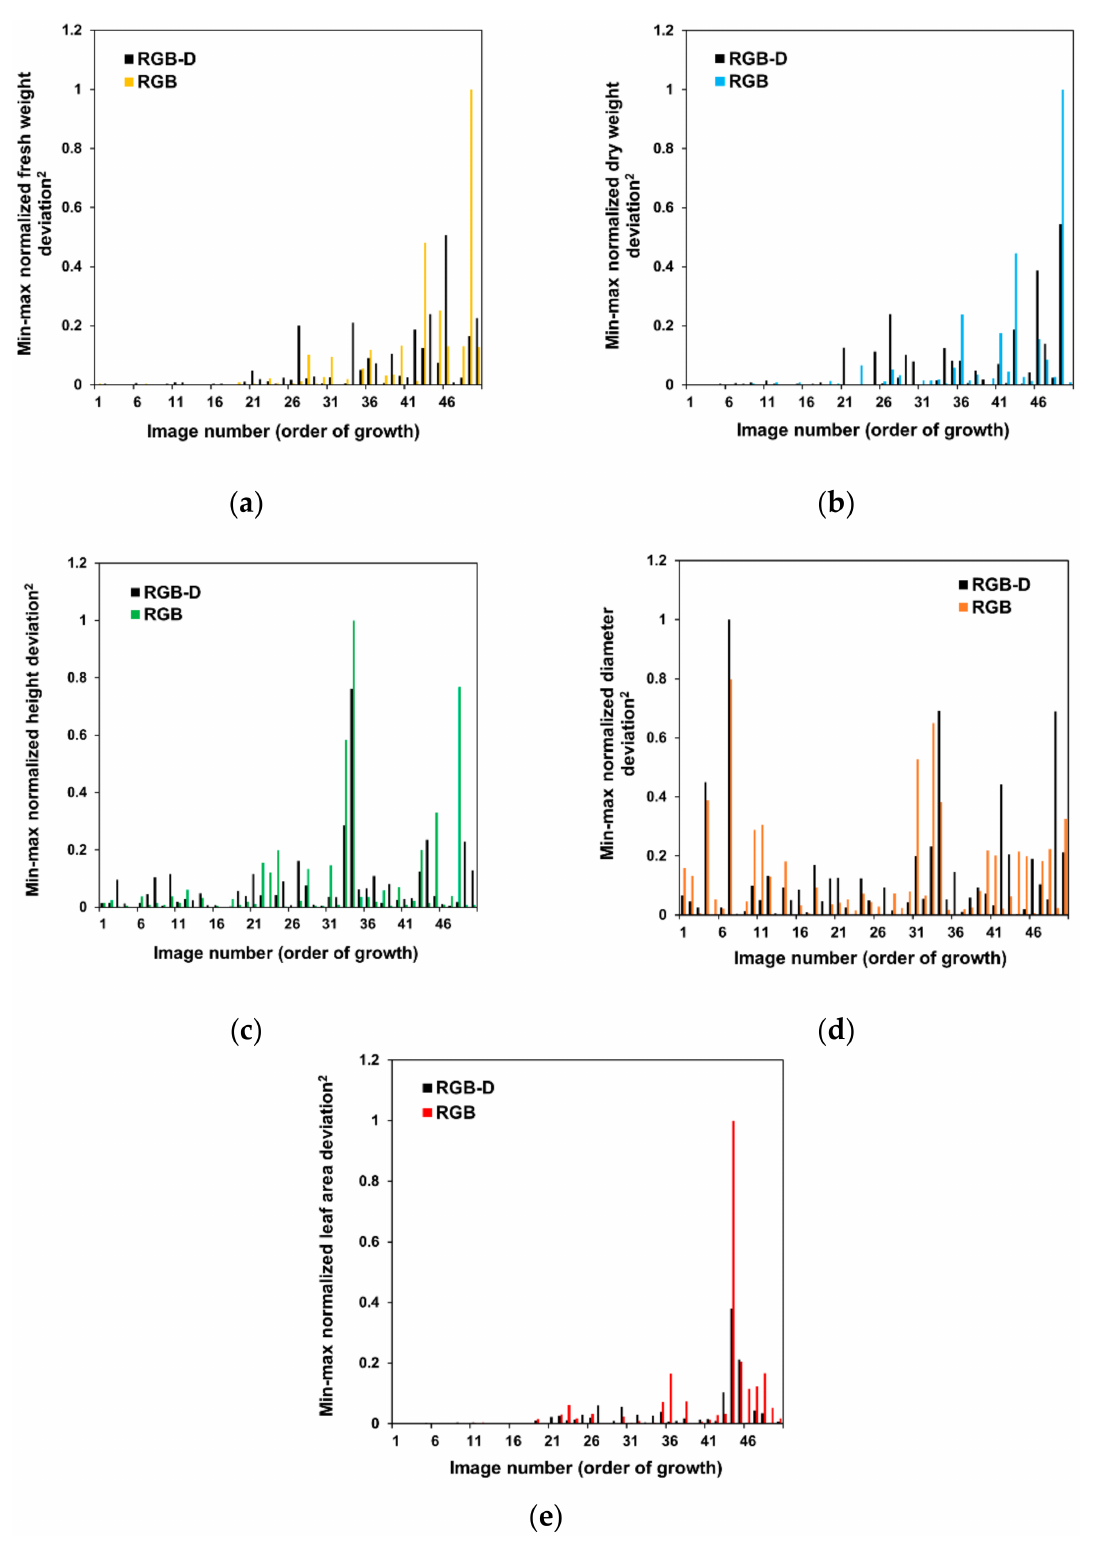
Figure 8. Comparison of growth index estimation of the developed two-stage CNN model using RGB-D images and RGB images in 20 samples in the late growth stage: ( a ) fresh weight, ( b ) dry weight, ( c ) height, ( d ) diameter, and ( e ) leaf